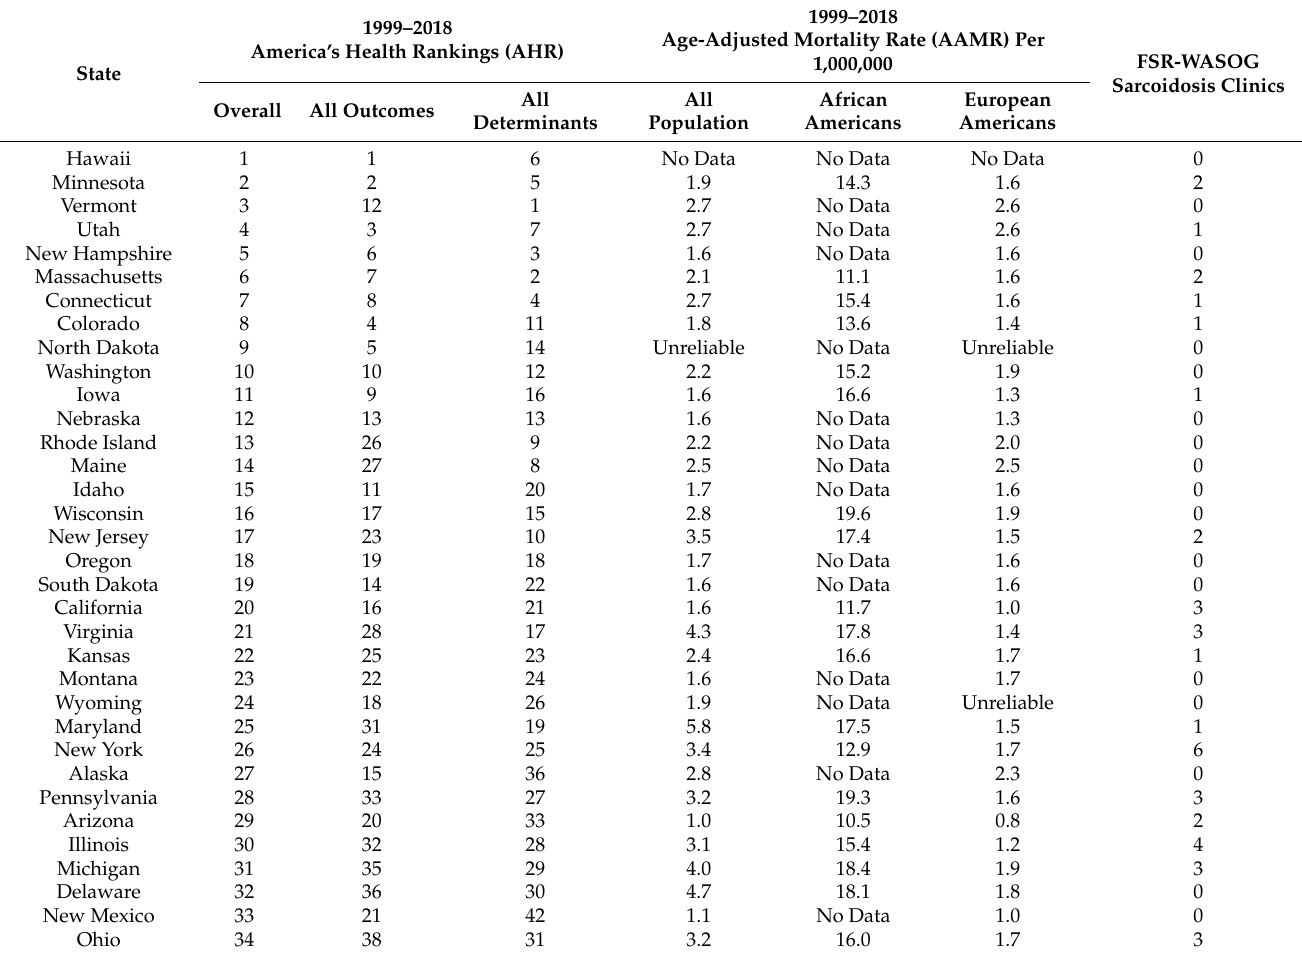
Table 1. Summary of State Health Rankings, Sarcoidosis-Related Age-Adjusted Mortality Rate, and FSR-WASOG (Founda- tion for Sarcoidosis Research-World Association for Sarcoidosis and Other Granulomatous Disorders) Sarcoidosis Clinics of 50